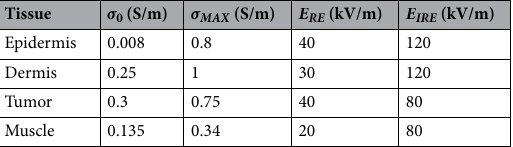
Table 1. Electrical parameters of tissues used in the tumor case simulations 25,43 .